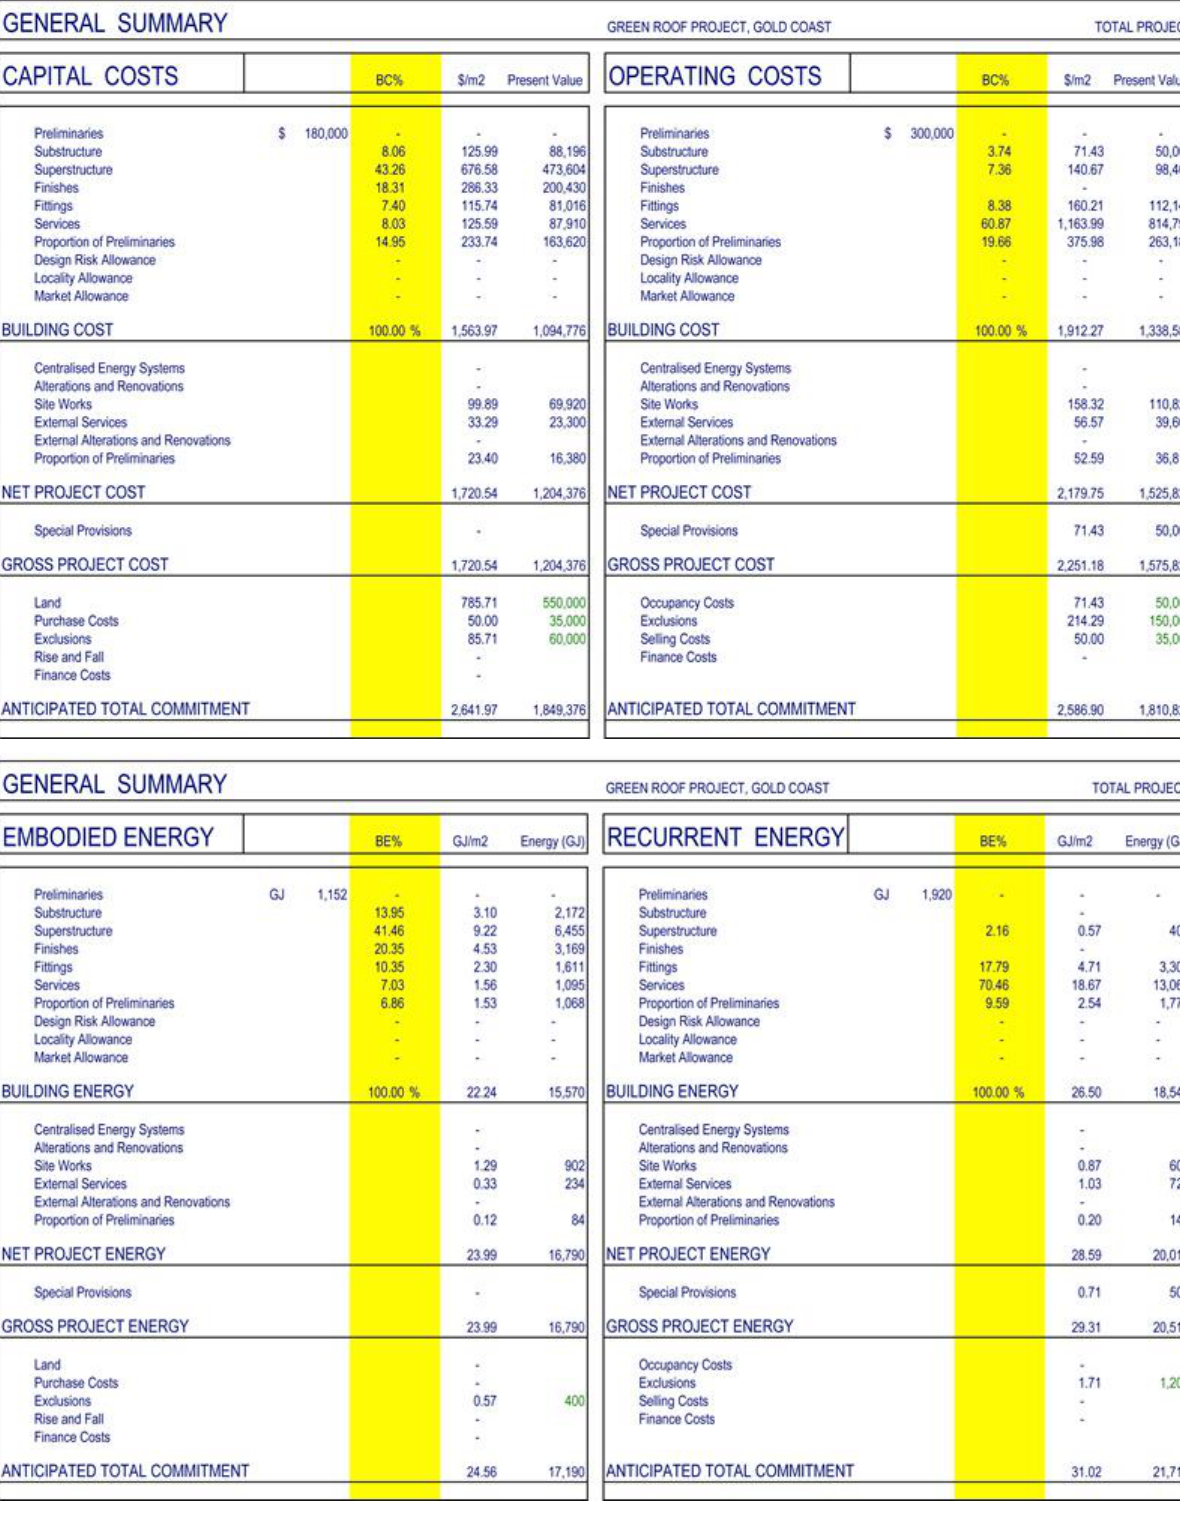
Figure 5: Green roof project cost and energy